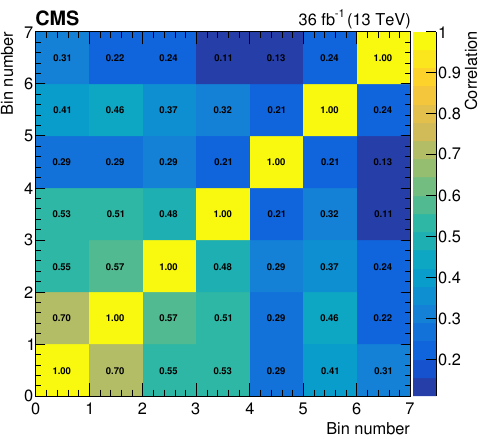
Figure 18 . Correlations between background predictions in each of the bins of the loose signal region, after performing the (cid:12)t in only the control regions.